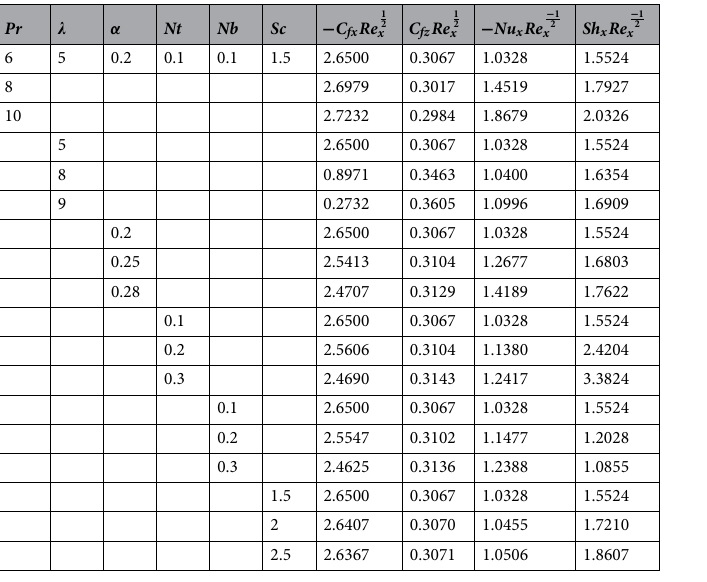
C fx and C fz , Nusselt Number Nu x , and (cid:31) (cid:30)